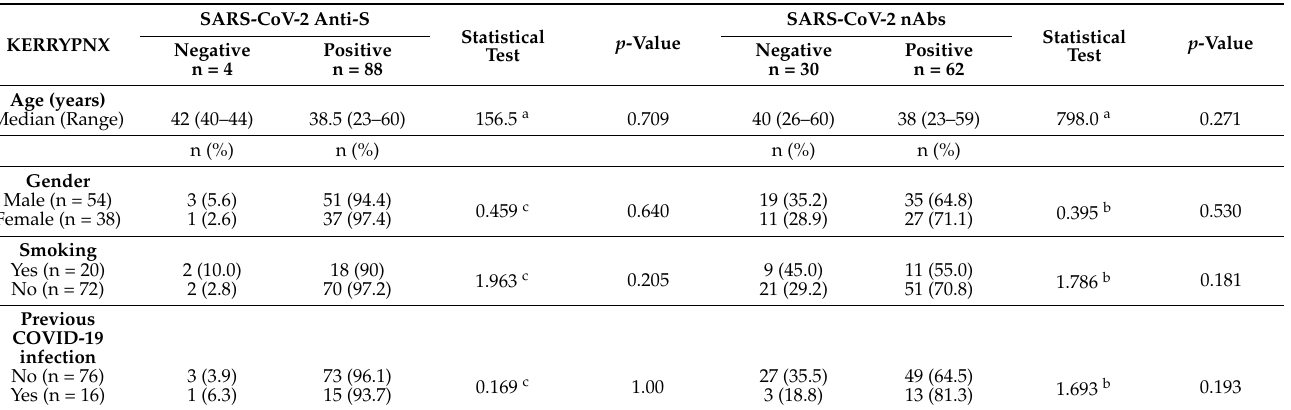
Table 5. Association between the seroprevalence of SARS-CoV-2 anti-S and nAbs and some character- istics of 92 Sinopharm vaccine recipients.